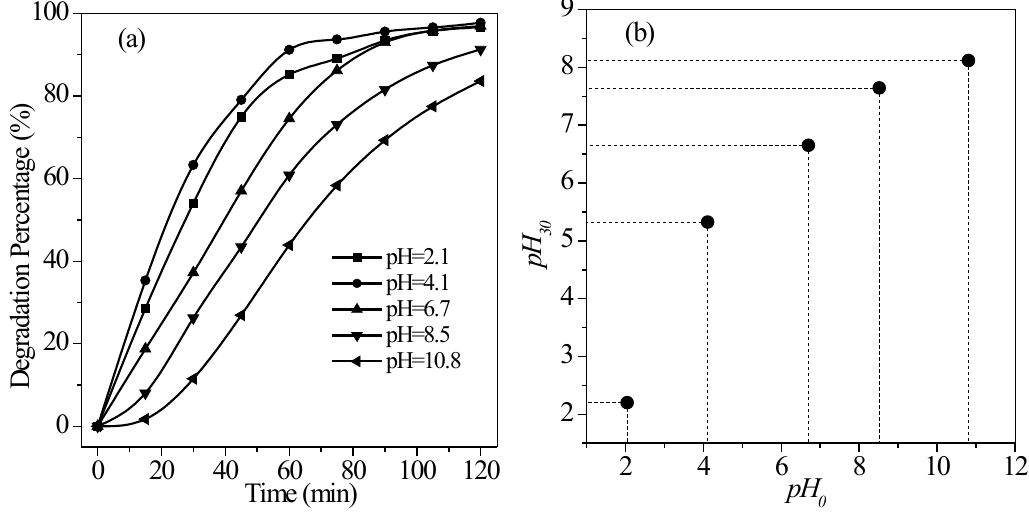
Figure 10. Effect of pH ( a ) on the photocatalytic degradation of quinoline and ( b ) after irradiation for 30 min. Conditions: flow rate = 0.35 L/min, T = 17 °C, C the maximum irradiation intensity. pH solution after UV irradiation for 0 and 30 min,